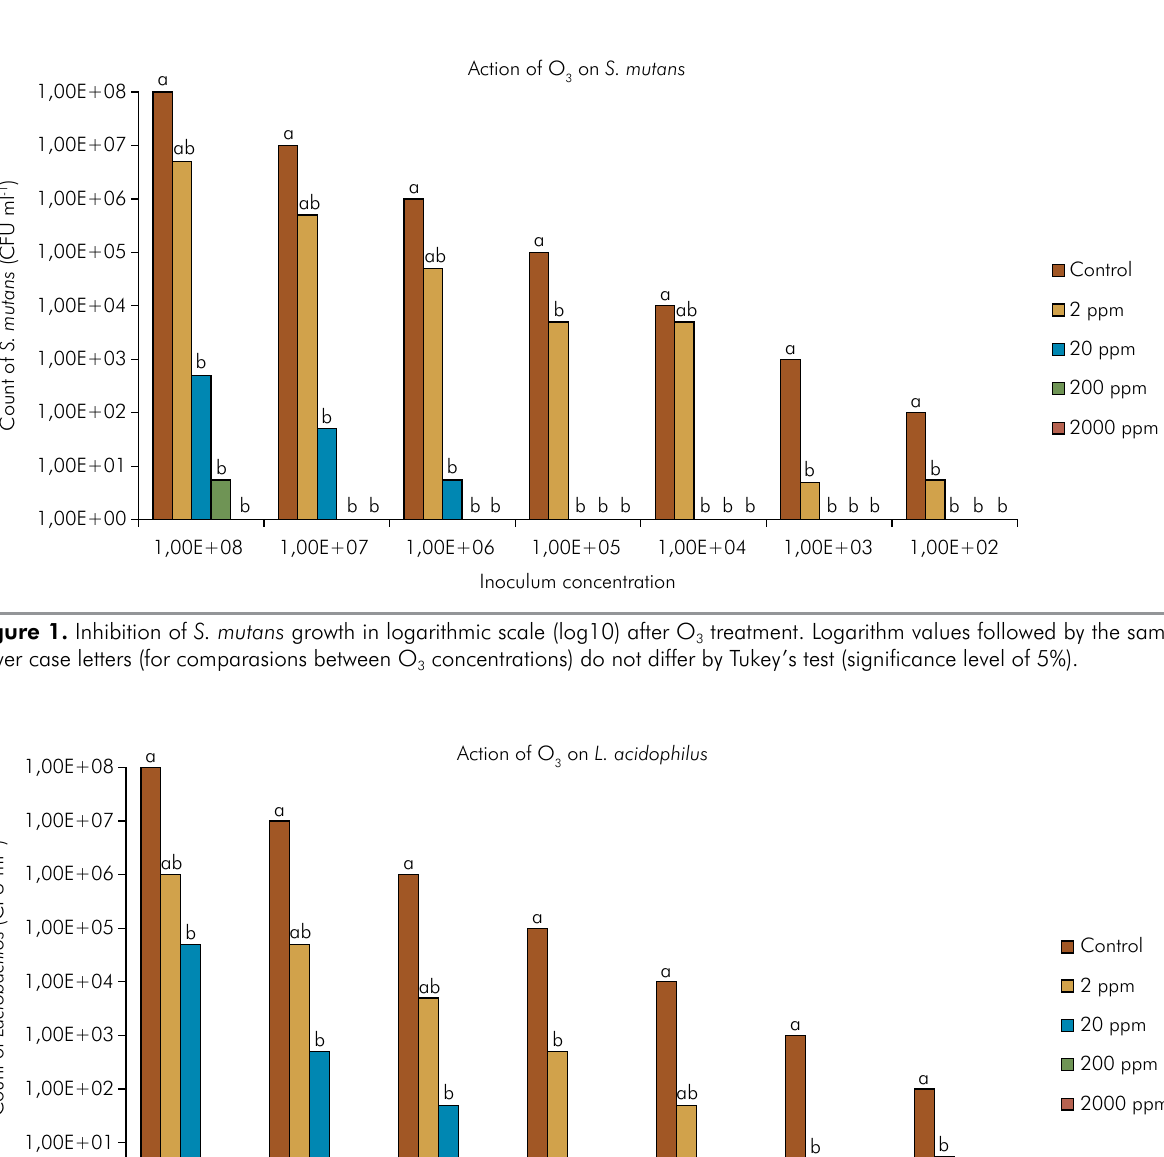
) after O treatment. Logarithm values followed by the same 10 3 concentrations) do not differ by Tukey’s test (significance level of 3